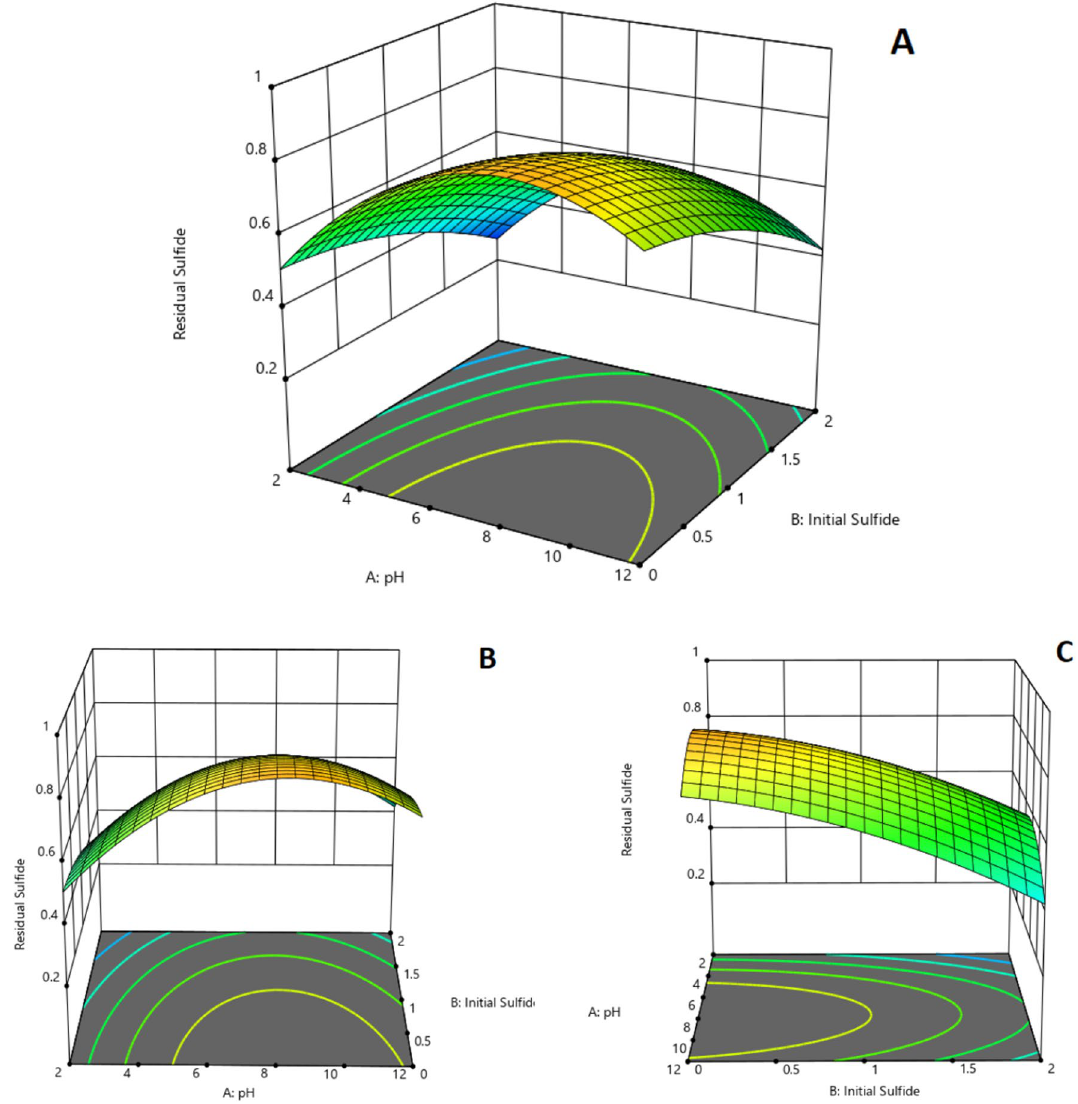
Figure 9. The 3-D plot of resulted model from D. X v.13 which indicates the behavior of response with factors and illustrates optimum condition.